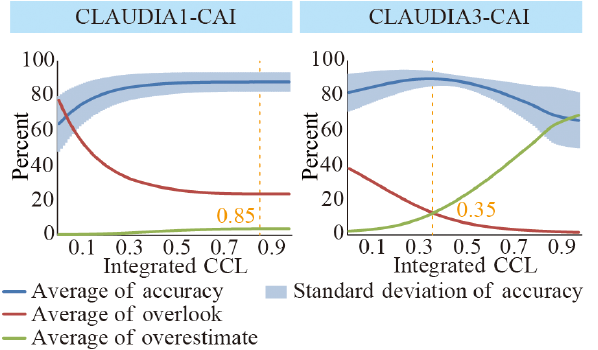
Figure 14. Comparison of the visual inspection images and the out- put images in Borneo. Orange circles indicate the maximum accu- racy values. Orange dotted lines indicate the integrated-CCL thresh- olds. Blue line indicates the accuracy, red line indicates the over- look, and green line indicates the